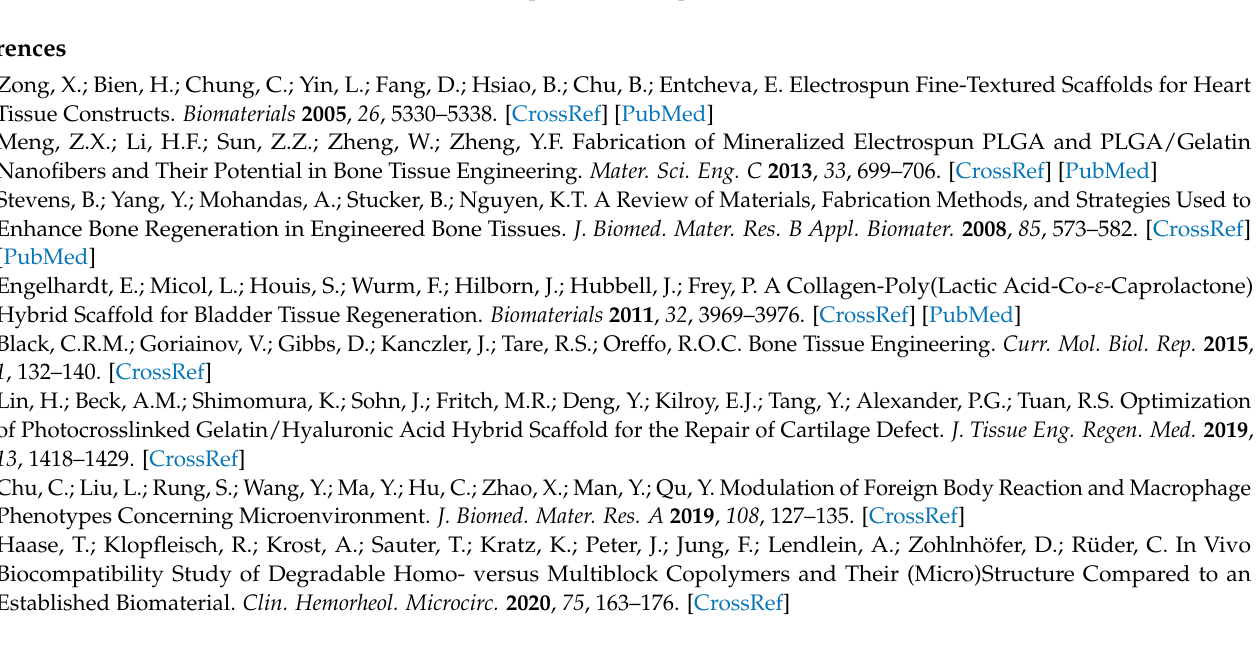
COL scaffolds ( b ); Ratio of the intensity of the red peak at 658 nm to the intensity of the green one at a wavelength of 544 nm of 1% UCNPs and UCNPs released from ELS COL scaffolds into PBS ( c ); Figure S7: Confocal images of 3D HAGM 0,1% ( a ) and 3D HAGM 1% ( b ) scaffolds cultured with Bj-5ta fibroblasts, 8 days incubation. Green is for Calcein AM staining (alive cells), blue is for Hoechst 33342 staining (cell nucleuses); Figure S8: Confocal images of ELS PLG ( a ), ELS PLG 0,1% ( b ), and ELS PLG 1% ( c ) scaffolds cultured with Bj-5ta fibroblasts, 8 days incubation. Blue is for Hoechst 33342 staining (cell nucleuses), no Calcein AM staining. Scale bar is 400 µ m; Figure S9: Custom-designed electrospinning set-up. 1—Polymer solution supply system, 2—Syringe, 3—Stainless steel capillary, 4—Aluminum foil collector, 5—High voltage supply; Figure S10: 3D printer for antisolvent printing. 1—Stepper motor, 2—Needle, 3—Syringe, 4—Pump, 5—PC, 6—Samples, 7—Petri dish, 8—Motor guides; Figure S11: Extrusion 3D printer with laser sources at a wavelength of 445 nm.